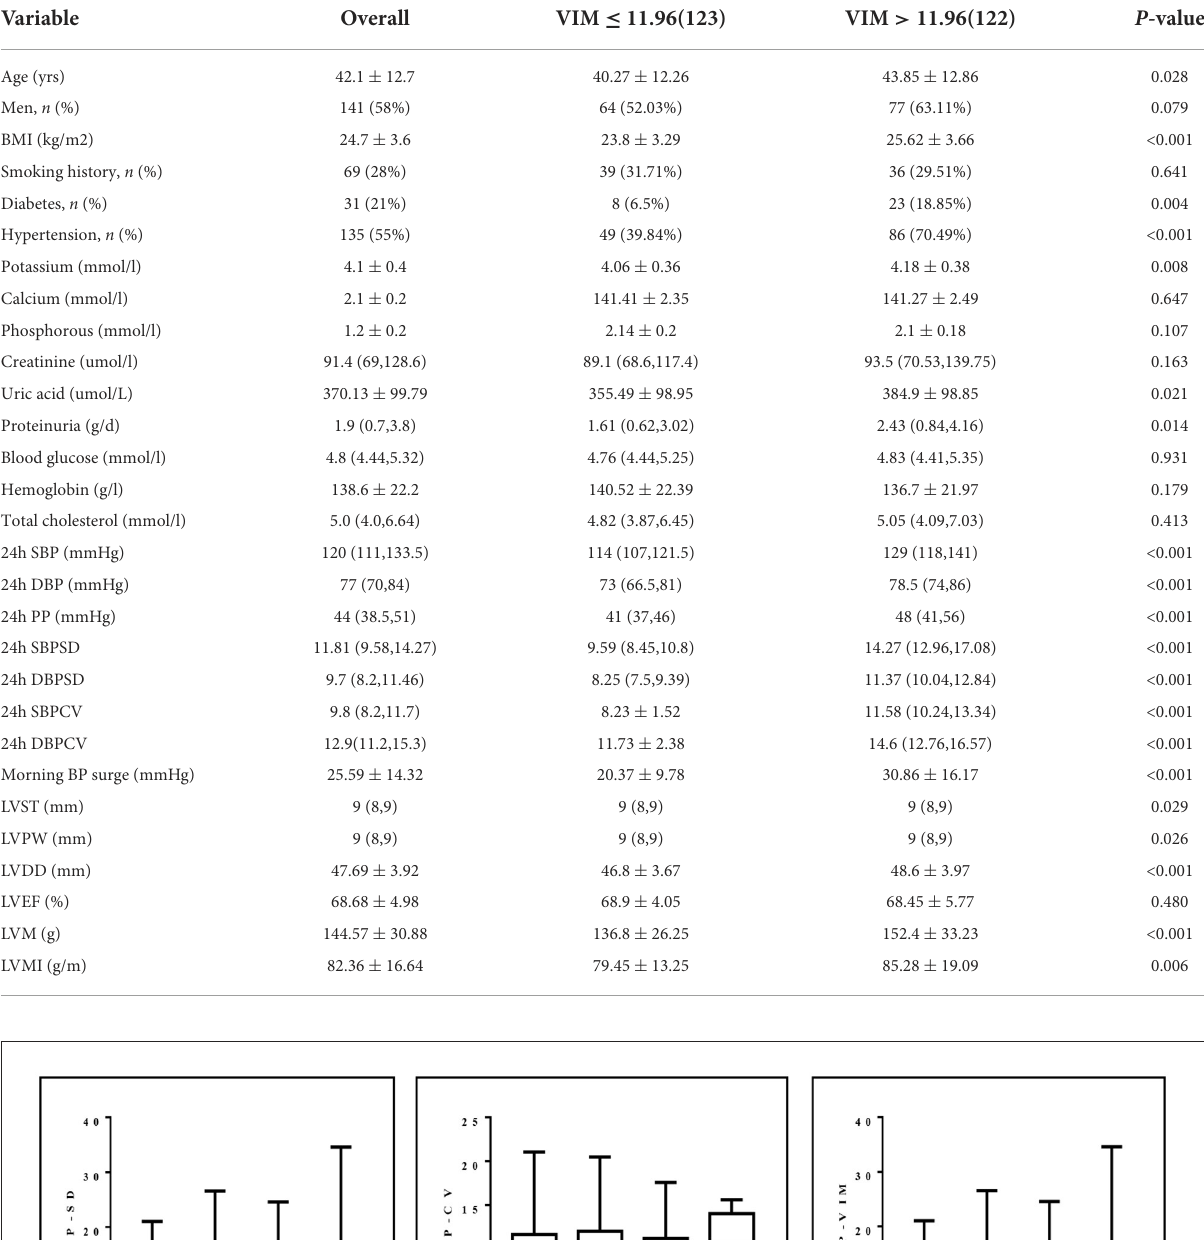
TABLE 1 Baseline demographics, clinical characteristics, and 24-h ambulatory BP parameters, in the study cohort composed of 245 patients with CKD.